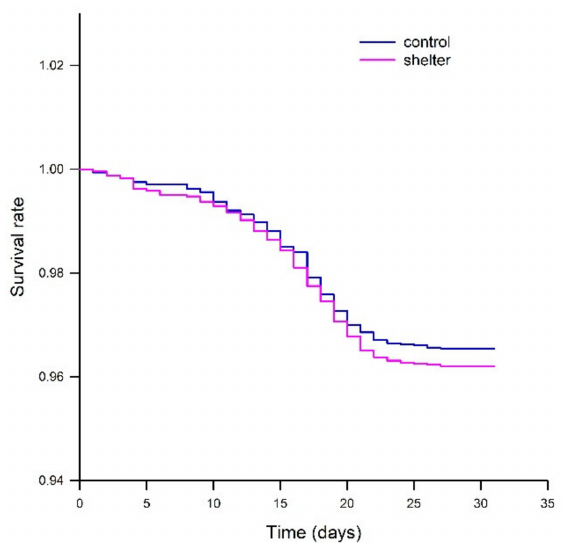
Figure 4. Kaplan-Meier survival curves for rainbow trout ( Oncorhynchus mykiss ) fingerlings in Control and Shelter groups during the experimental period. Mortality data from the different replicated tanks was merged for each treatment. Initial fish numbers were assumed equal for all tanks (1572 fish per tank). Treatment had no effects on survival (Log-rank, p =